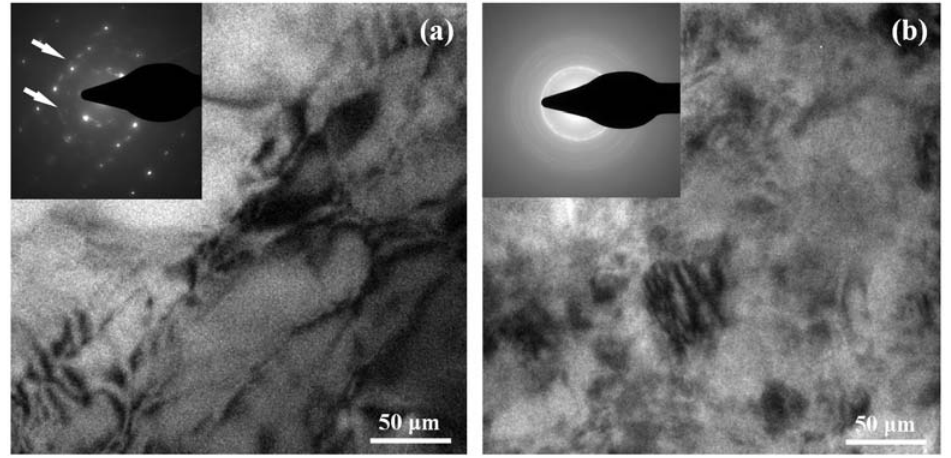
Figure 4. Transmission electron microscope (TEM) micrographs from the plasma ‐ oxidized samples at ( a ) 80 W for 10 min and ( b ) 280 W for 30 min.